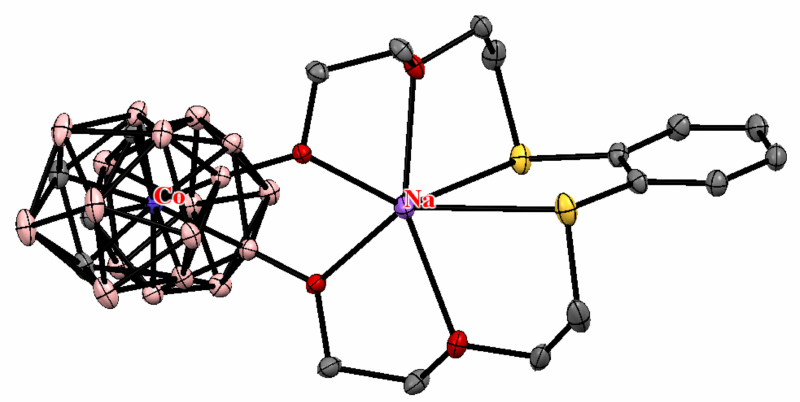
Figure 3. The molecular structure of Na[8,8 (cid:48) -(OCH 2 CH 2 OCH 2 CH 2 S) 2 - o -C 6 H 4 -3,3 (cid:48) -Co(1,2-C 2 B 9 H 9 ) 2 ]. By the ring-opening reactions of tetrahydrofuran and 1,4-dioxane derivatives of nido - carborane with sodium azide a series of nido -carborane-based azides with different spacer lengths between the nido -carborane cage and functional group was synthesized [60,80,81] (Scheme